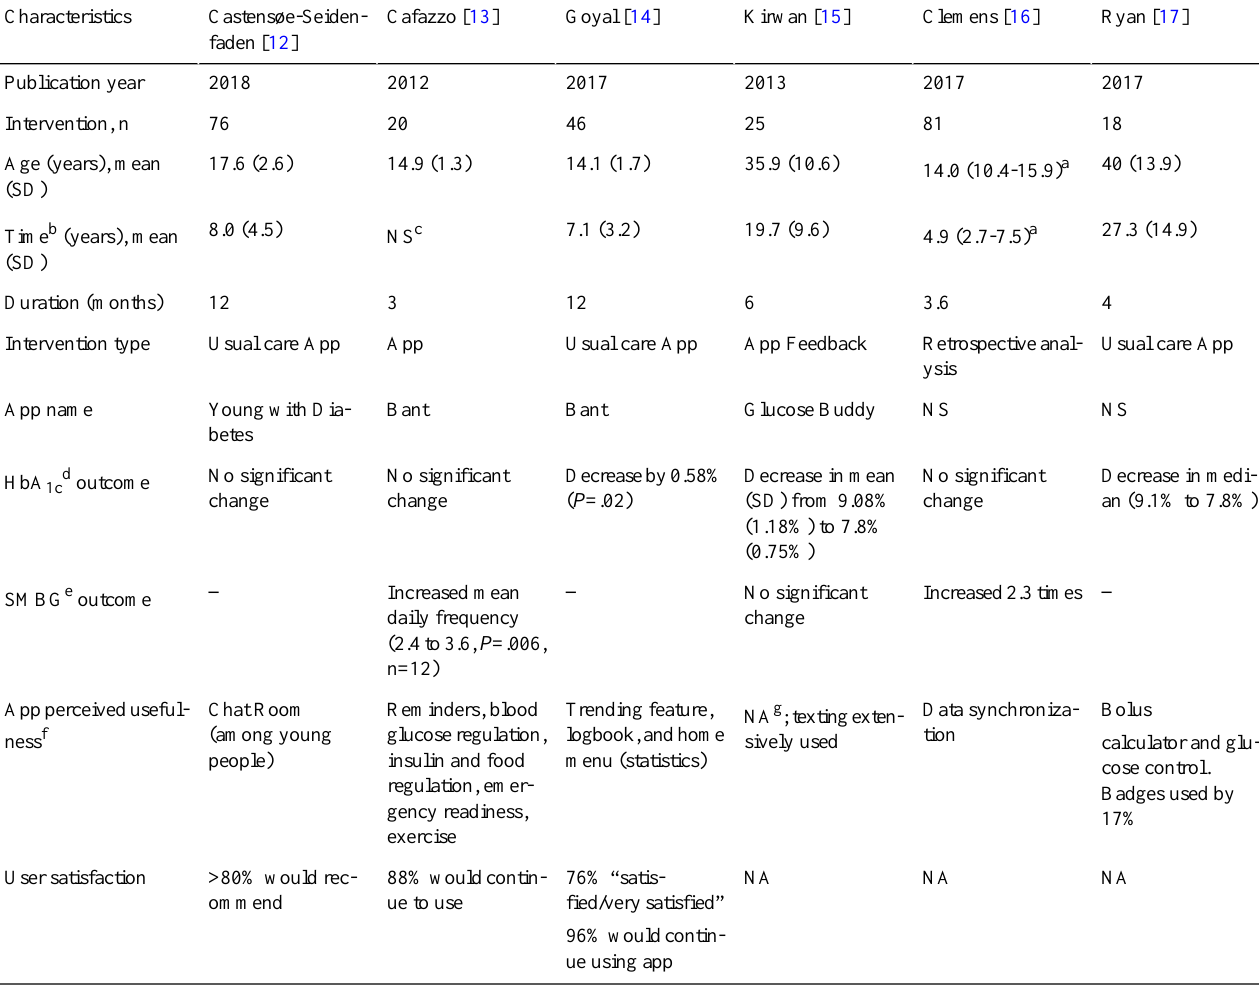
Table 1. Characteristics of the studies evaluating mobile apps for type 1 diabetes mellitus management and